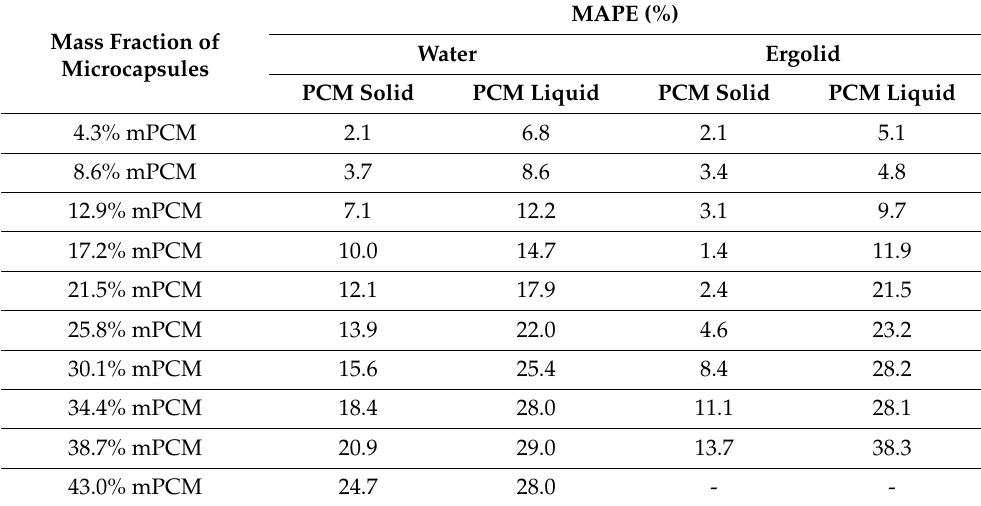
Table 3. The mean absolute percentage error of the determination of the thermal conductivity of mPCM